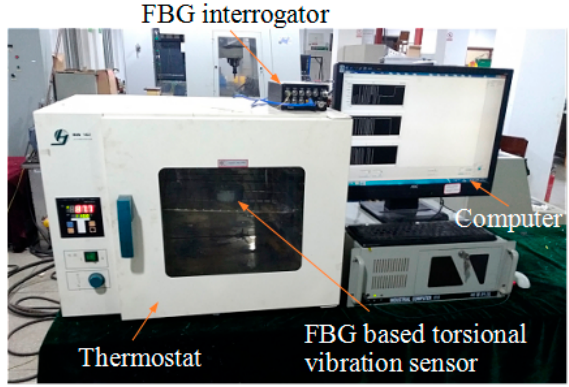
Figure 15. Temperature influence testing system. Sensors 2017 , 17 , x FOR PEER REVIEW